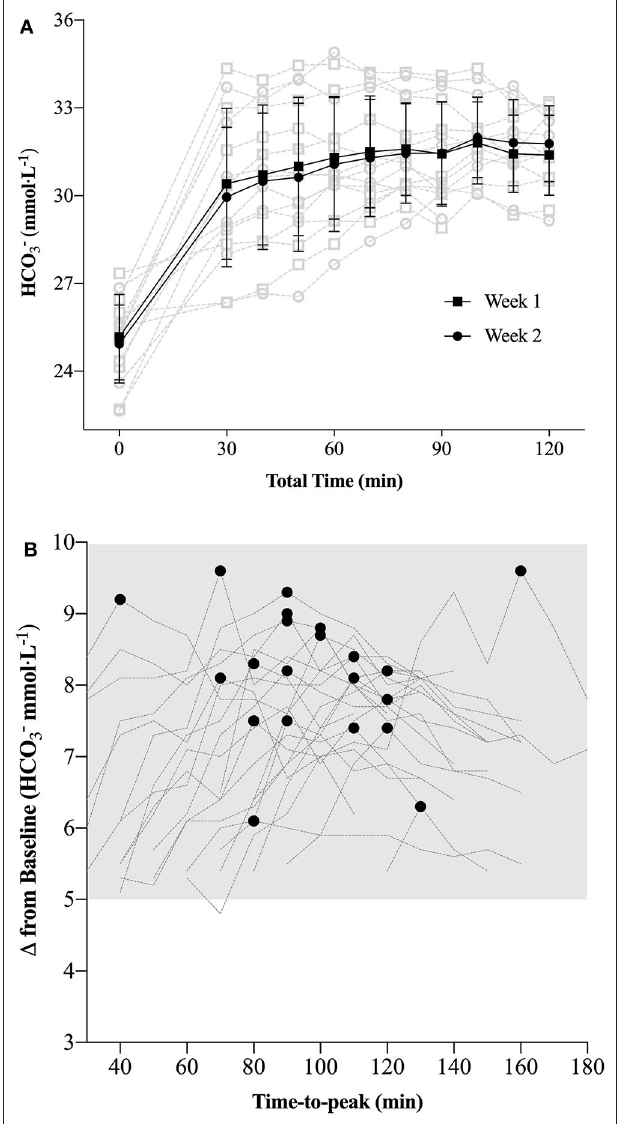
FIGURE 2 | (A) Week-to-week standard bicarbonate concentrations ([sHCO − 3 ]) (mean ± SD: black; individual data: light gray) observed during the pilot study [ n = 8; (A) ]; (B) : Individual ( n = 23) participant measurements of peak and corresponding time-to-peak as observed during the Individualized NaHCO 3 Loading Profile trial. Each individual’s time-to-peak was subsequently used to demarcate the time frame prior to commencing the time trial (TT) in the Individualized Peak (IP) trial.